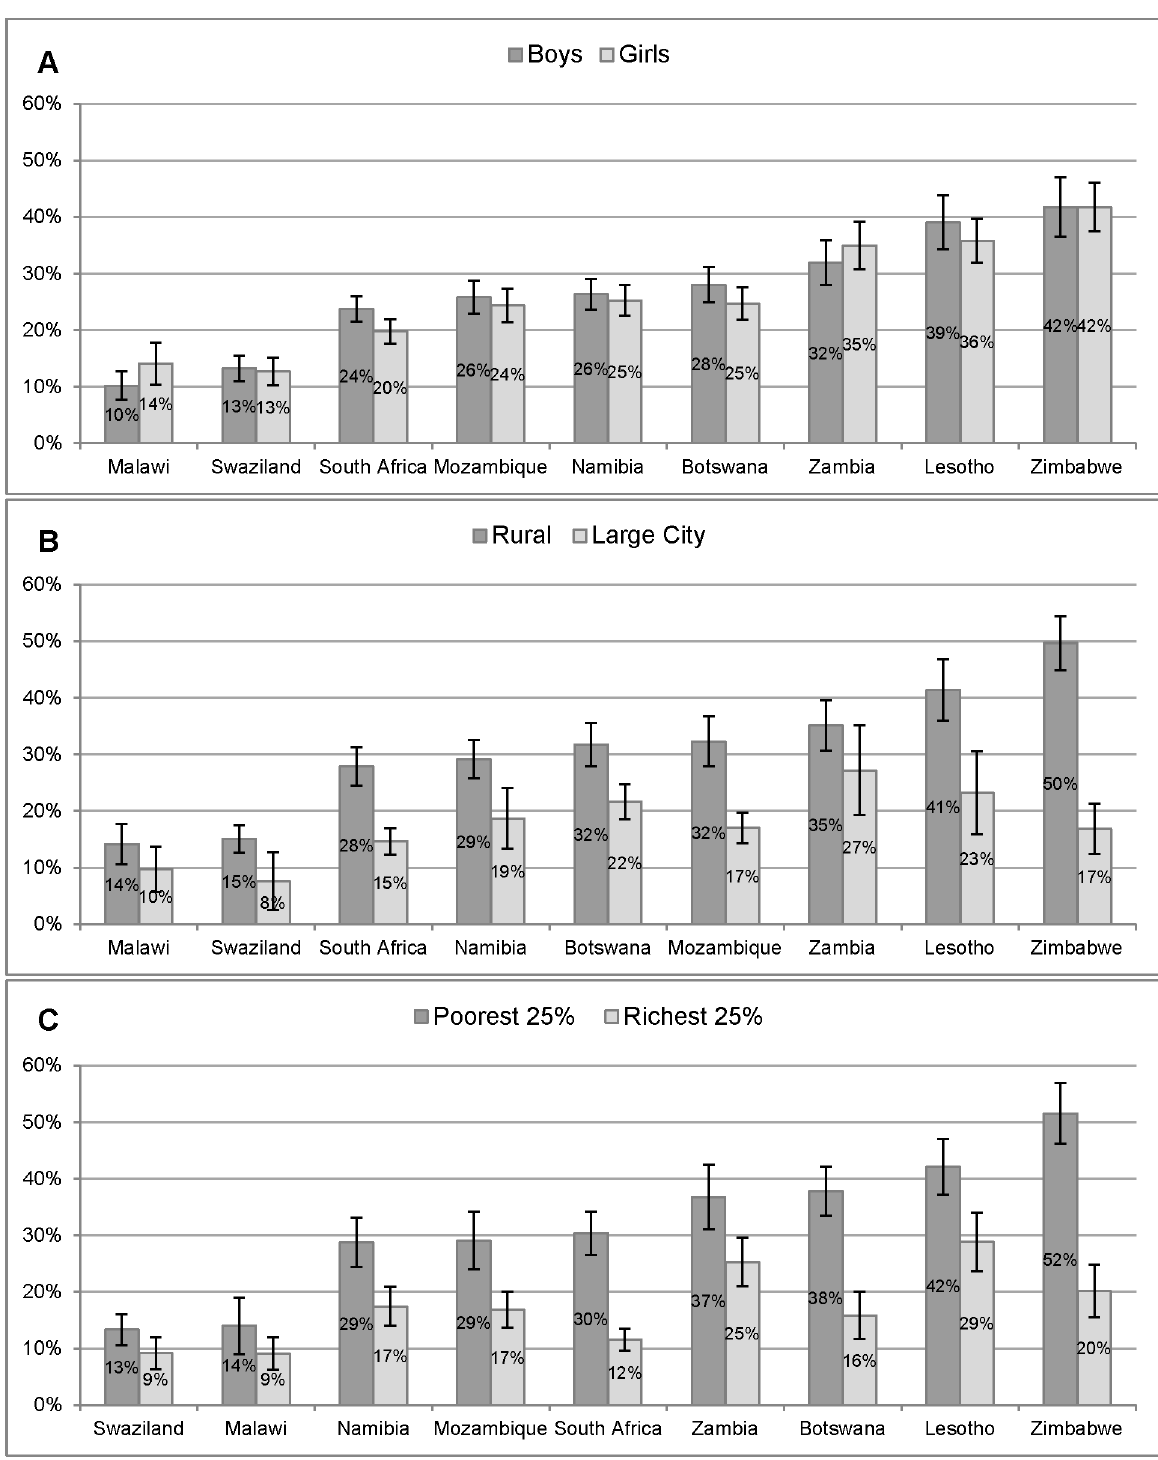
Figure 2. Beliefs that a student living with HIV should not be allowed to attend school. Proportion of grade 6 students who believed that students living with HIV should not be allowed to continue to attend school, by gender (Figure 2A), geographic location (Figure 2B) and wealth quartile (Figure 2C) including 95% confidence interval.